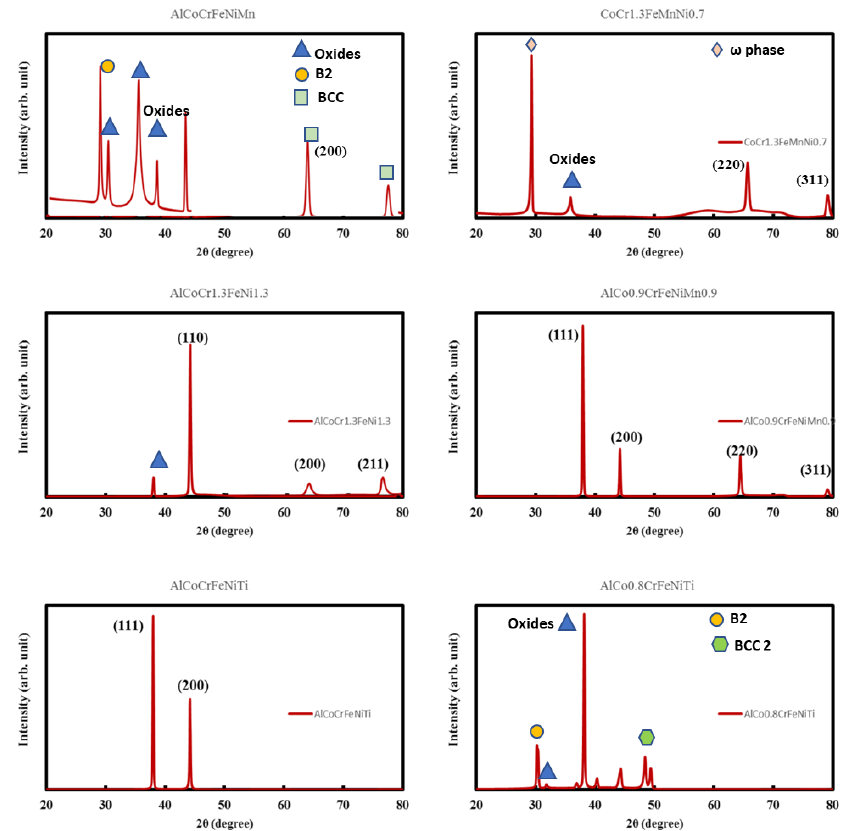
Figure 6. X-Ray diffractograms of shortlisted HEAs. It can be seen that most of the alloys are free from secondary phases. We have observed both FCC and BCC lattice in these cases.